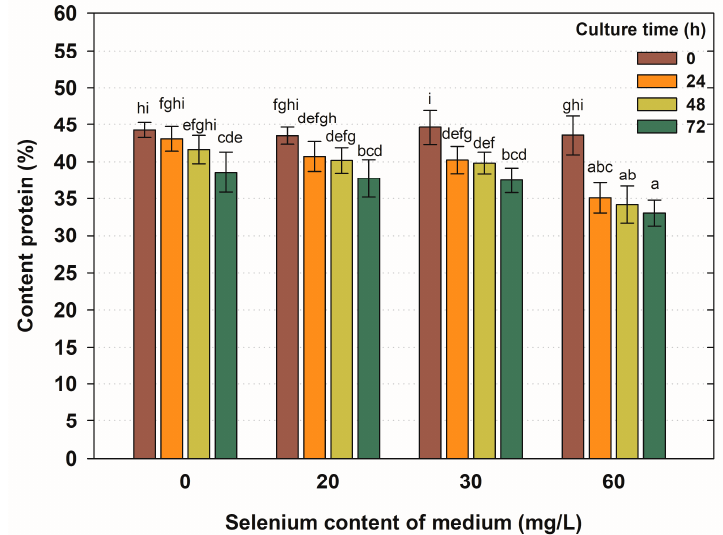
Figure 4. Changes in total protein content (%) in C. utilis yeast cells after cultivation in the control (YPD) and in the experimental media enriched with selenium in the form of Na 2 SeO 3 . a − i Means with the same letter did not differ significantly ( p < 0.05).